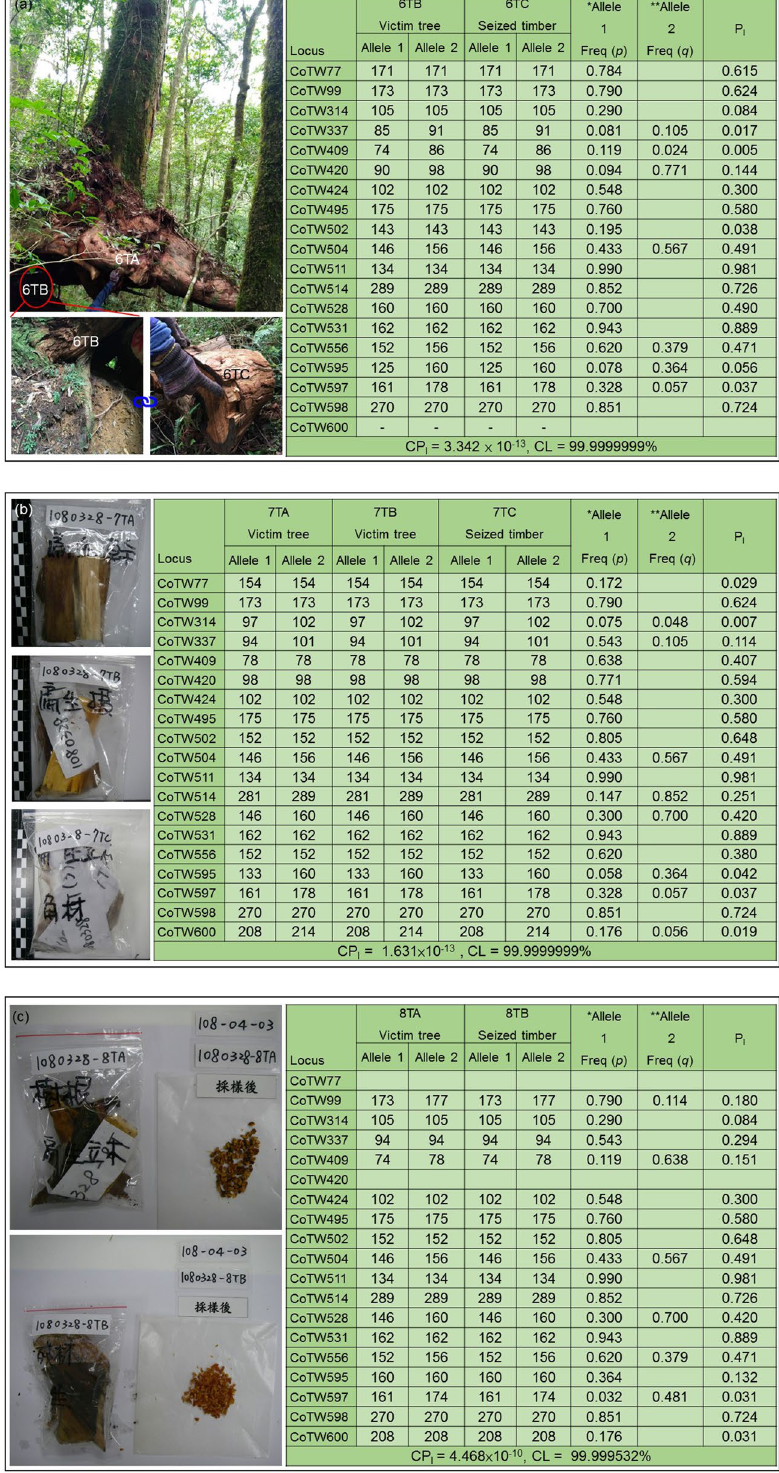
Figure 2. The photos and matrices of the three groups in which seized timbers and victim trees are successfully linked via 19 non-linked SSR markers matches. ( a ) Group 6TB/6TC, in wild. ( b ) Group 7TA/7TB/7TC, sampled. ( c ) Group 8TA/8TB, chopped. *A1 Freq Allele 1 Frequency. **A2 Freq = Allele 2 Frequency. Allele frequencies are from 96 individuals of C. taiwanensis . P I = p 2 or 2 pq . CP I combined probability of identity, CL confidence